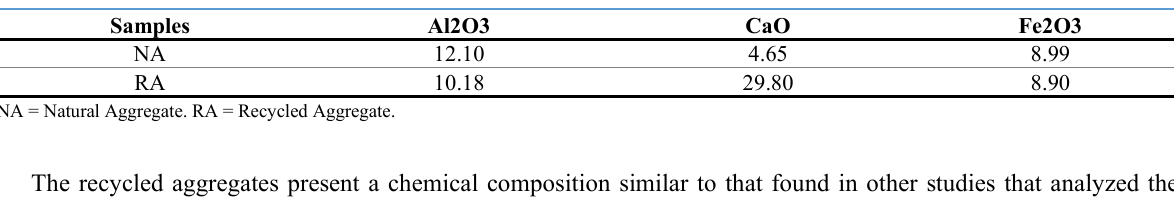
Table 6. X Ray fluorescence test